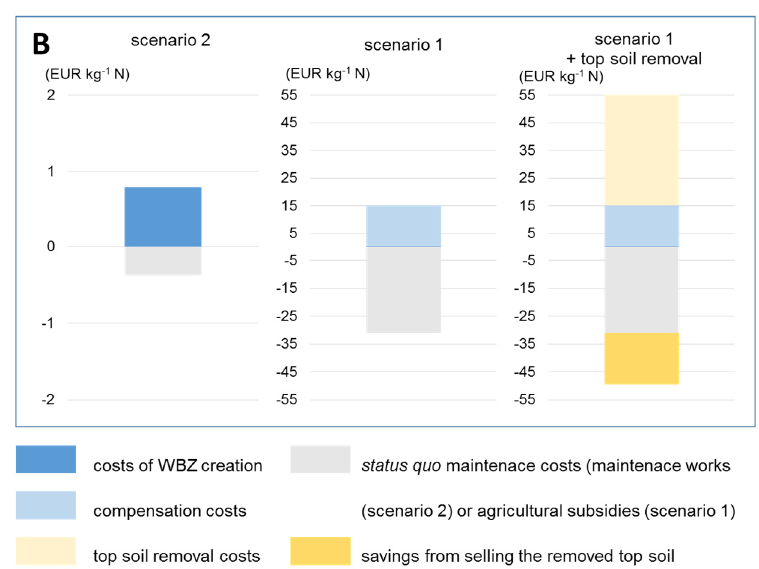
Figure 4. Costs of creation and functioning of WBZs in scenario 1 (with or without the top soil removal option) and scenario 2; averaged for five sub-catchments; N removal assessed in a “median” variant. ( A ) Costs re-calculated for the amount of N removed in one year, compensation costs and current status quo maintenance costs spent in one year. ( B ) Costs re-calculated for the amount of N removed in 30 years, compensation costs and status quo maintenance costs spent in 30 years (assuming maintenance works performed every five years). Agricultural subsidies include current direct payment (319 EUR ha − 1 year − 1 —in a farm of 3–30 ha, with one cow per hectare [60] and agri-environment-climate schemes payment (on average 248 EUR ha − 1 year − 1 ).